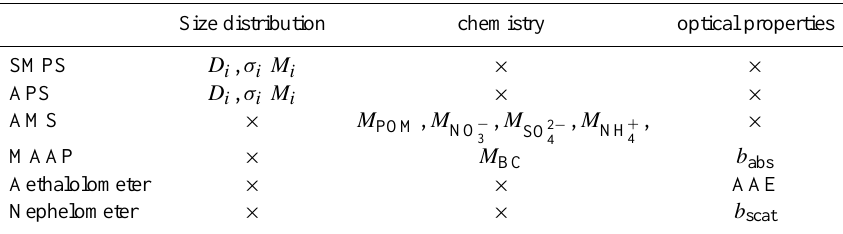
Fig. 7. Diagram representation of the methodology used for the validation. ρ is the density considered for the aerosol particle. i is the index of the aerosol lognormal mode. M i is the aerosol mass concentration value for the i -th mode obtained from the lognormal fit adjusted on the SMPS+APS size distribution observations. M sd is the total mass concentration deduced from the fit of the SMPS+APS size distribution observations. M sd, 500 is the mass concentration calculated from the fit of the SMPS+APS size distribution observations integrated up to 500nm. M POM , M NH , M SO , M NO , is the particle organic matter, ammonium, sulfate, nitrate mass concentration respectively measured 4 4 3 by the AMS. M BC is the black carbon mass concentration deduced from the MAAP. M ch, 500 is the mass concentration deduced from the AMS+MAAP observations up to 500nm. b abs , obs , 670 is the absorption coefficient measured by the MAAP at the wavelength of 670nm. AAE abs , obs is the absorption Angstr¨om coefficient measured by the aethalometer. MEE is th Mass extinction efficiency. Table 3. Summary of aerosol measurements on Cabauw tower during the EUCAARI campaign. Size distribution chemistry optical